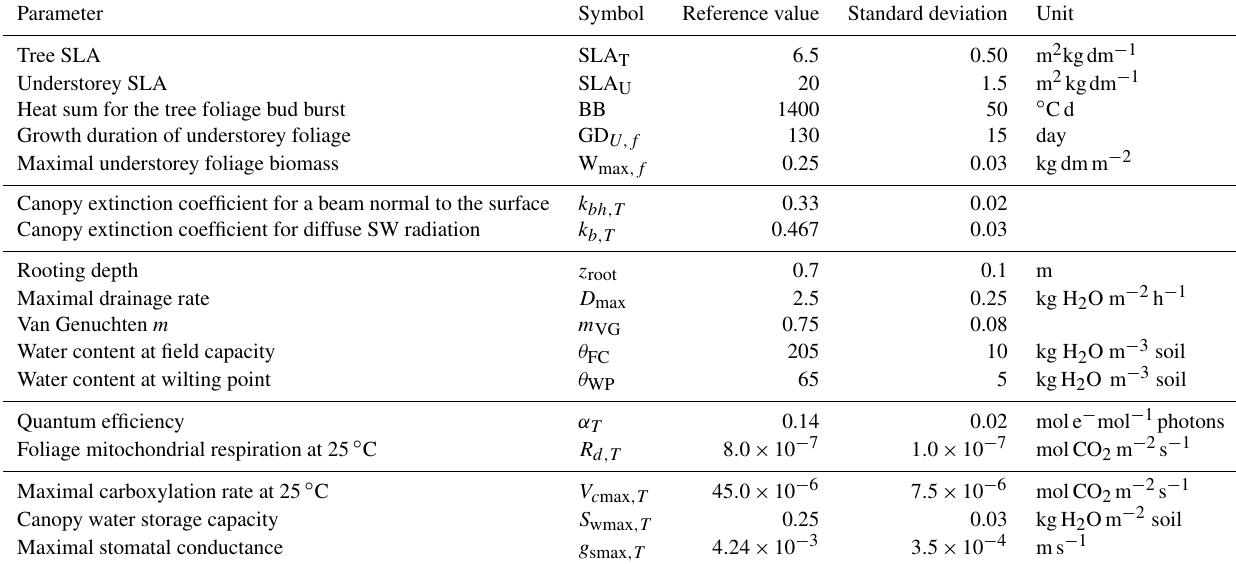
Table 3. List of the parameters used for uncertainty propagation in the GO+ model, their reference value and standard deviation. Parameter Symbol Reference value Tree